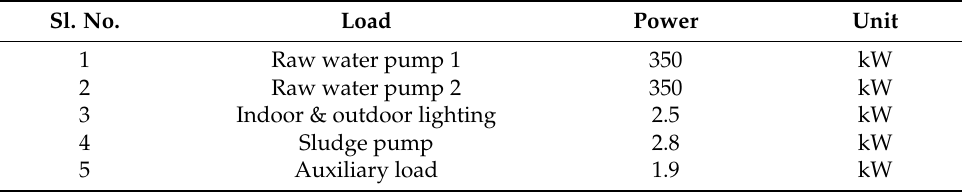
Table 1. Various loads of the microgrid system. Sl. No.